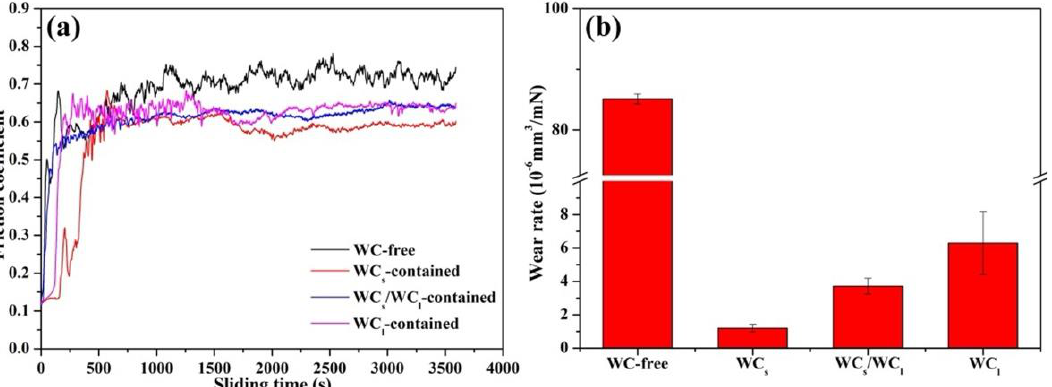
Figure 6. Variation in COF ( a ) and wear rate ( b ) of during LC of three clad layers of (Fe60 + WC) on 16 Mn steel based on WCs, WCl, and mix of WCs and WCl. Reproduced with permission from [60]. Copyright Elsevier, 2022.